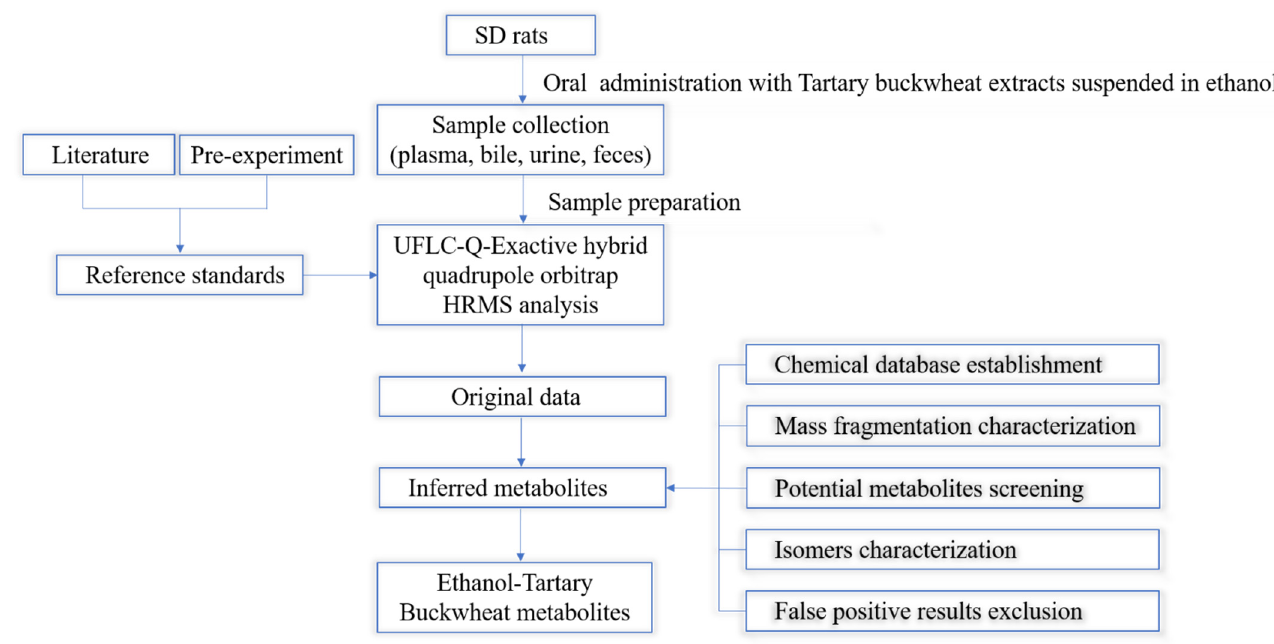
Figure 1. Established metabolite identification and analysis strategy for Tartary buckwheat extract metabolites in rats following co-administration of ethanol.